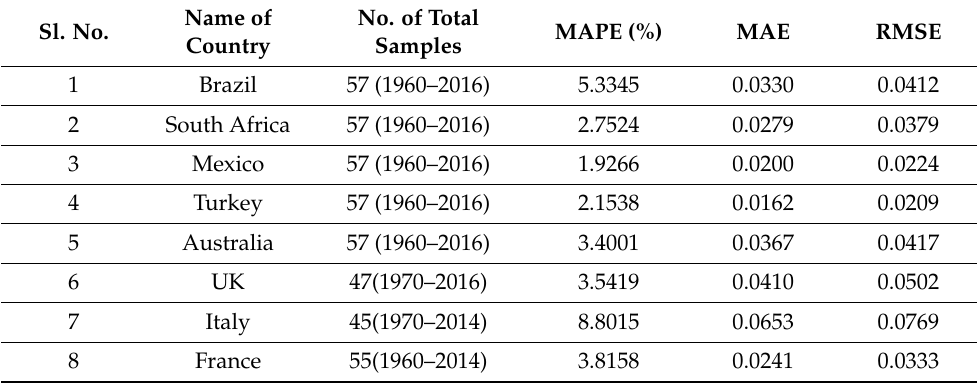
Table 3. MAPE, MAE and RMSE values obtained during testing for Group-2 countries. Sl.